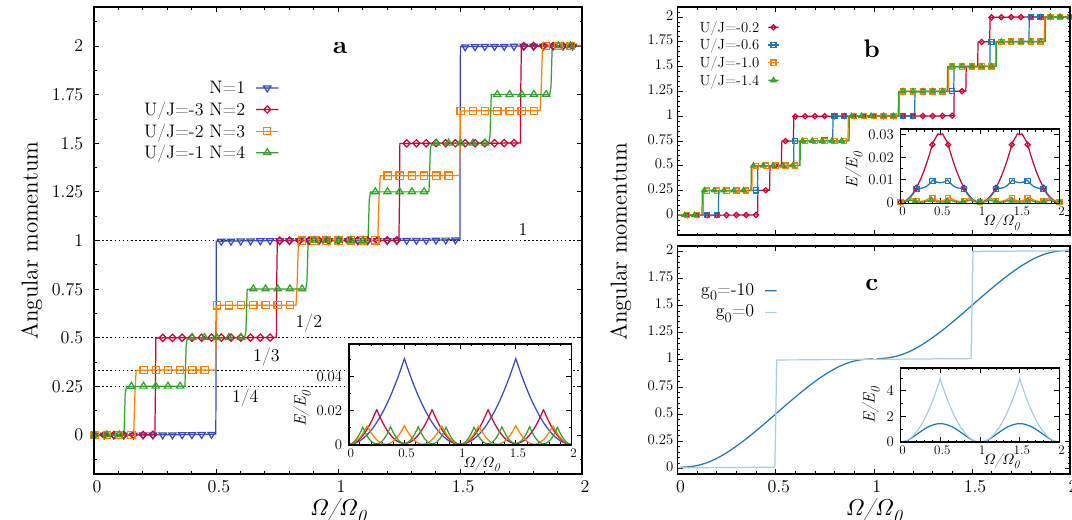
Figure 2: Average angular momentum per particle (main) and ground-state energy (inset) for bosons on a lattice ring as a function of artificial gauge field, from nu- merical exact diagonalization calculations: a ) at varying particle number, for chosen values of interaction strength as indicated on the figure, b ) for various values of in- teraction strength at fixed N = 4. Panel c ) shows the corresponding predictions from the mean-field Gross-Pitaevskii equation for zero and finite attractive interactions in- = mg L / (cid:126) 2 . The angular momentum per dicated by the dimensionless parameter g 0 M ef f particle is obtained as (cid:126) (cid:96) = M tive mass of the bound state in the lattice. Simulation have been carried out on a = 14 system of N s